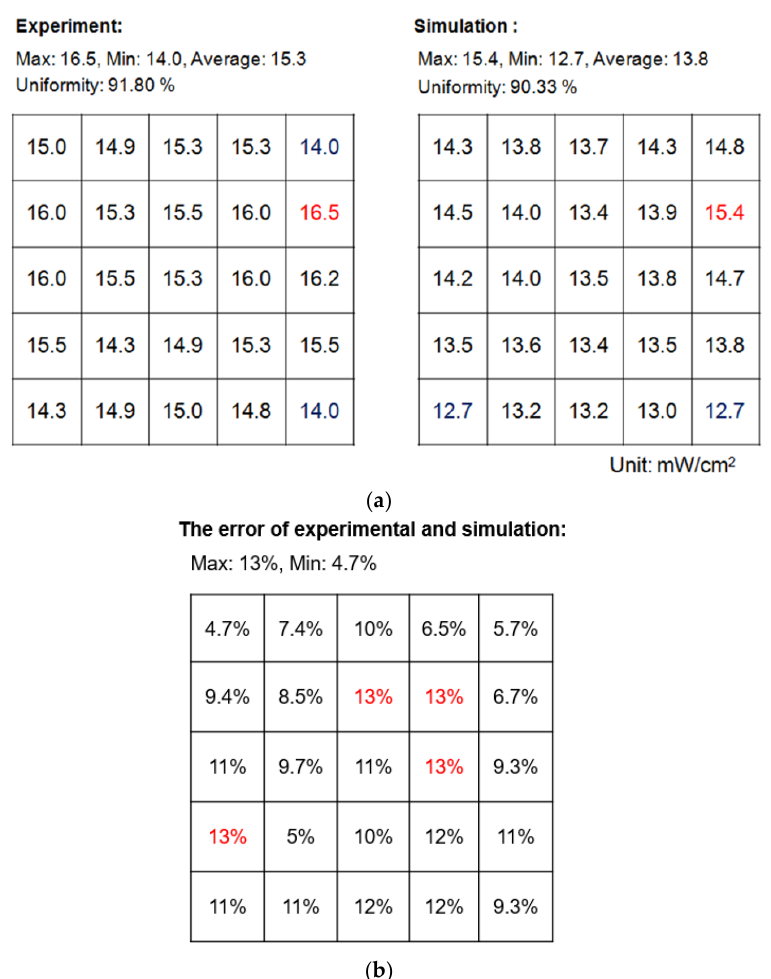
Figure 28. ( a ) The comparison of experimental and simulation of LED power adjustment type 2, ( b ) The error of experimental and simulation.